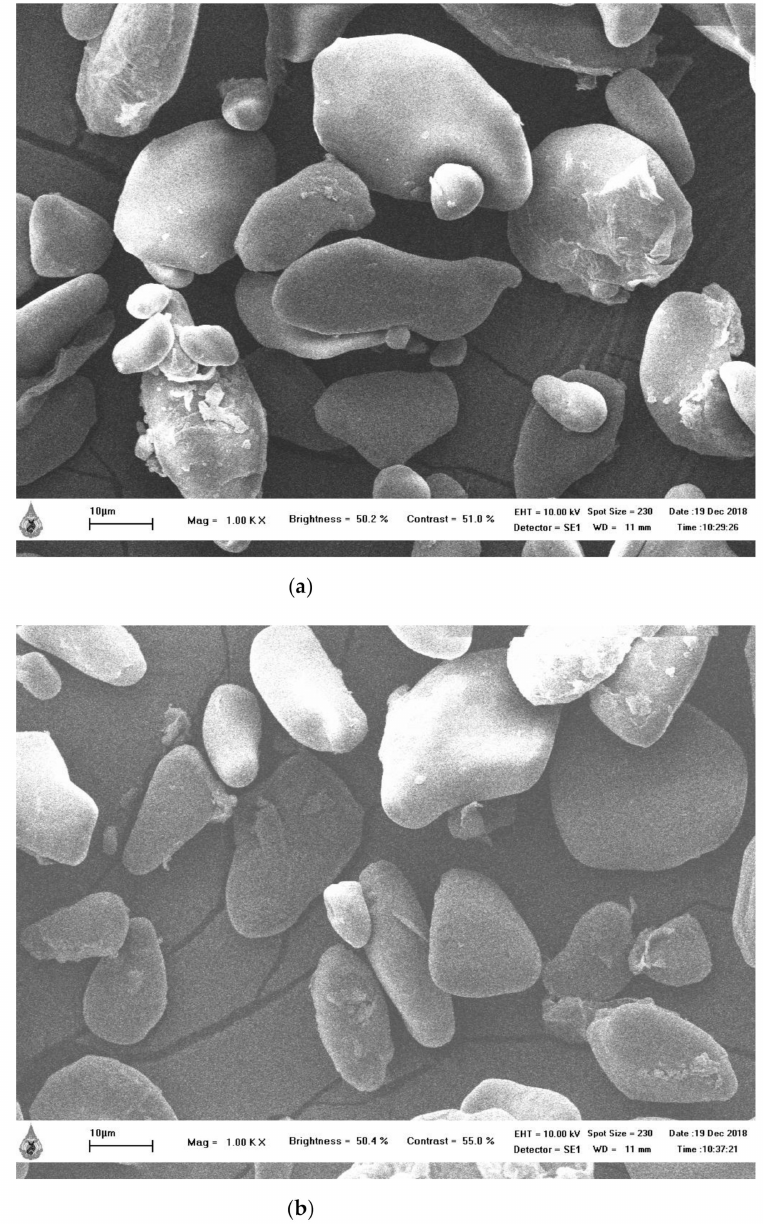
Figure 2. The morphology of banana starch at 1000 × ( a ) M. acuminata (AAA; HK) ( b ) M. sapientum L. (ABB;